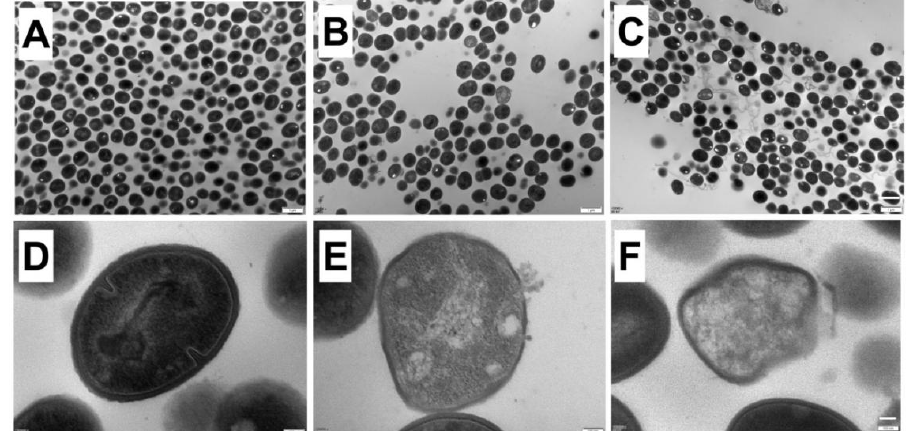
Figure 4. MRSA USA300 morphology investigated by transmission electron microscopy. ( A – C ) The morphology of USA300 strain in the control, 4 µg/mL SA2 treatment, and 8 µg/mL SA2 treatment group, respectively. The amplification of original magnification is 5000 times, Scale bar = 1 µm. ( D – F ) The morphology of USA300 strain in the control, 4 µg/mL, and 8 µg/mL SA2 treatment group, respectively. Scale bar = 100 nm. The amplification of original magnification is 50,000 times.